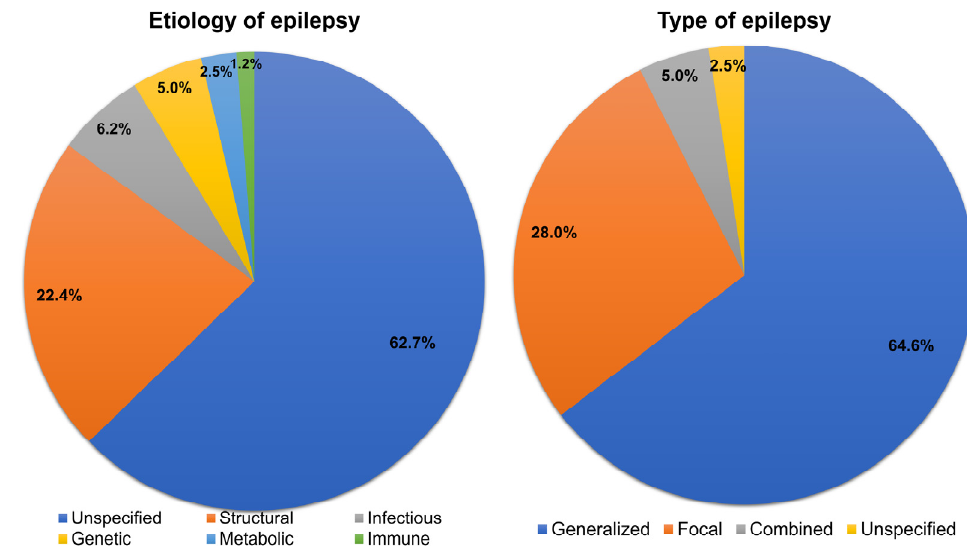
Figure 4. Etiology and type of epilepsy.